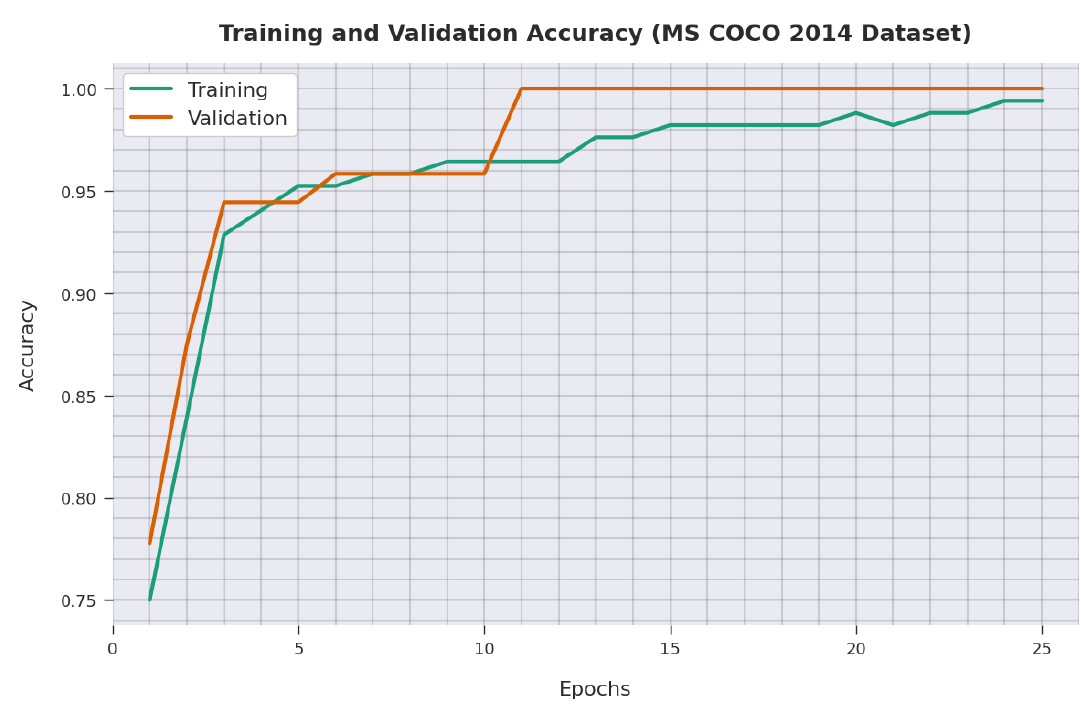
Figure 11. TA and VA analysis of MODLE-AICT technique on MS-COCO 2014 dataset.